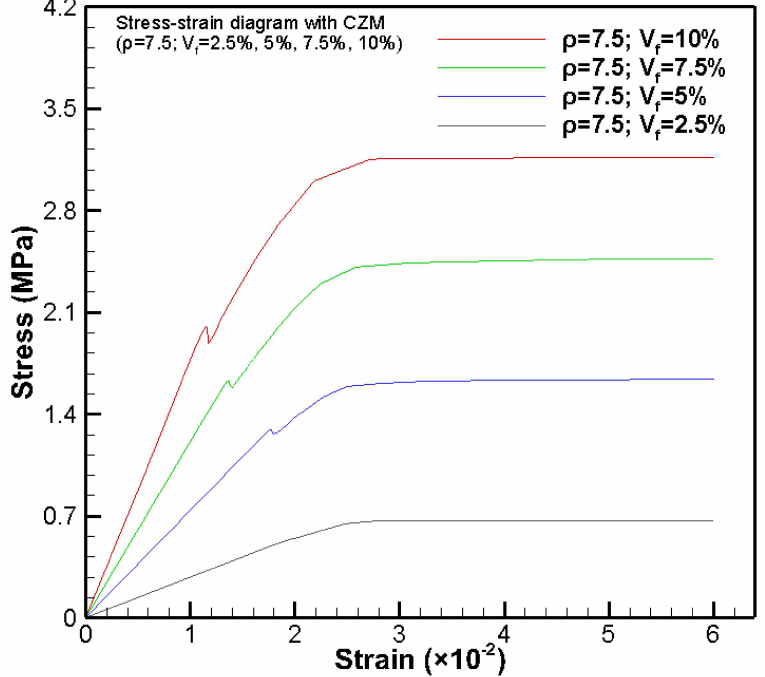
Figure 11. Effective stress-strain diagrams of the PNC (stack model) with CZM at the nanoparticle volume fraction of V f = 2.5%, 5%, 7.5%, and 10%, respectively (ρ = 7.5).